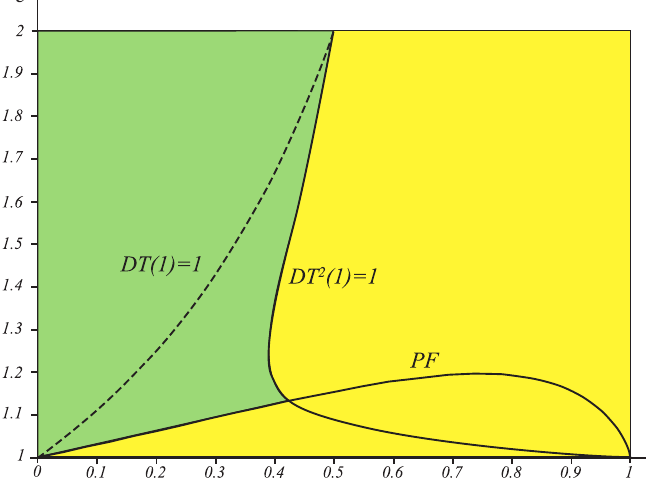
Fig. 13 Illustration to theorem 4: above the dotted line one has the expanding condition, and in the whole green region there are no stable periodic orbits. PF curve indicates the pitchfork